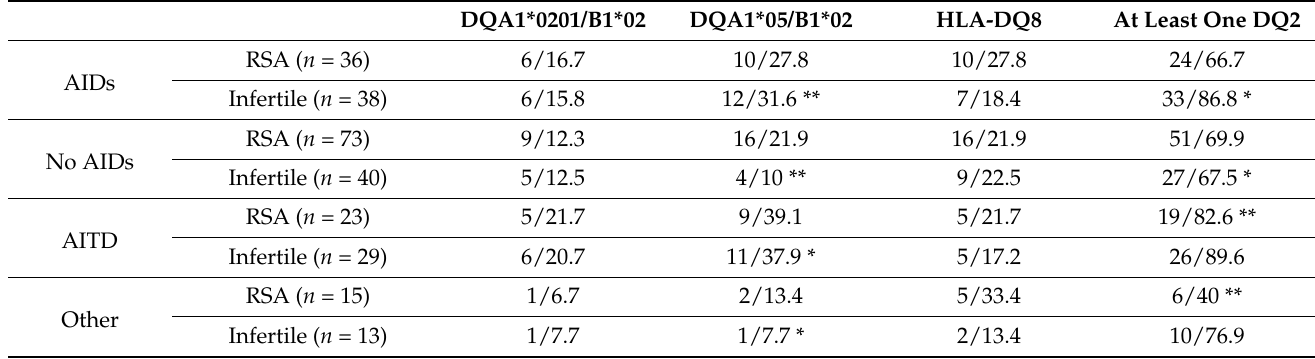
Table 2. HLA distribution in patients with or without autoimmune